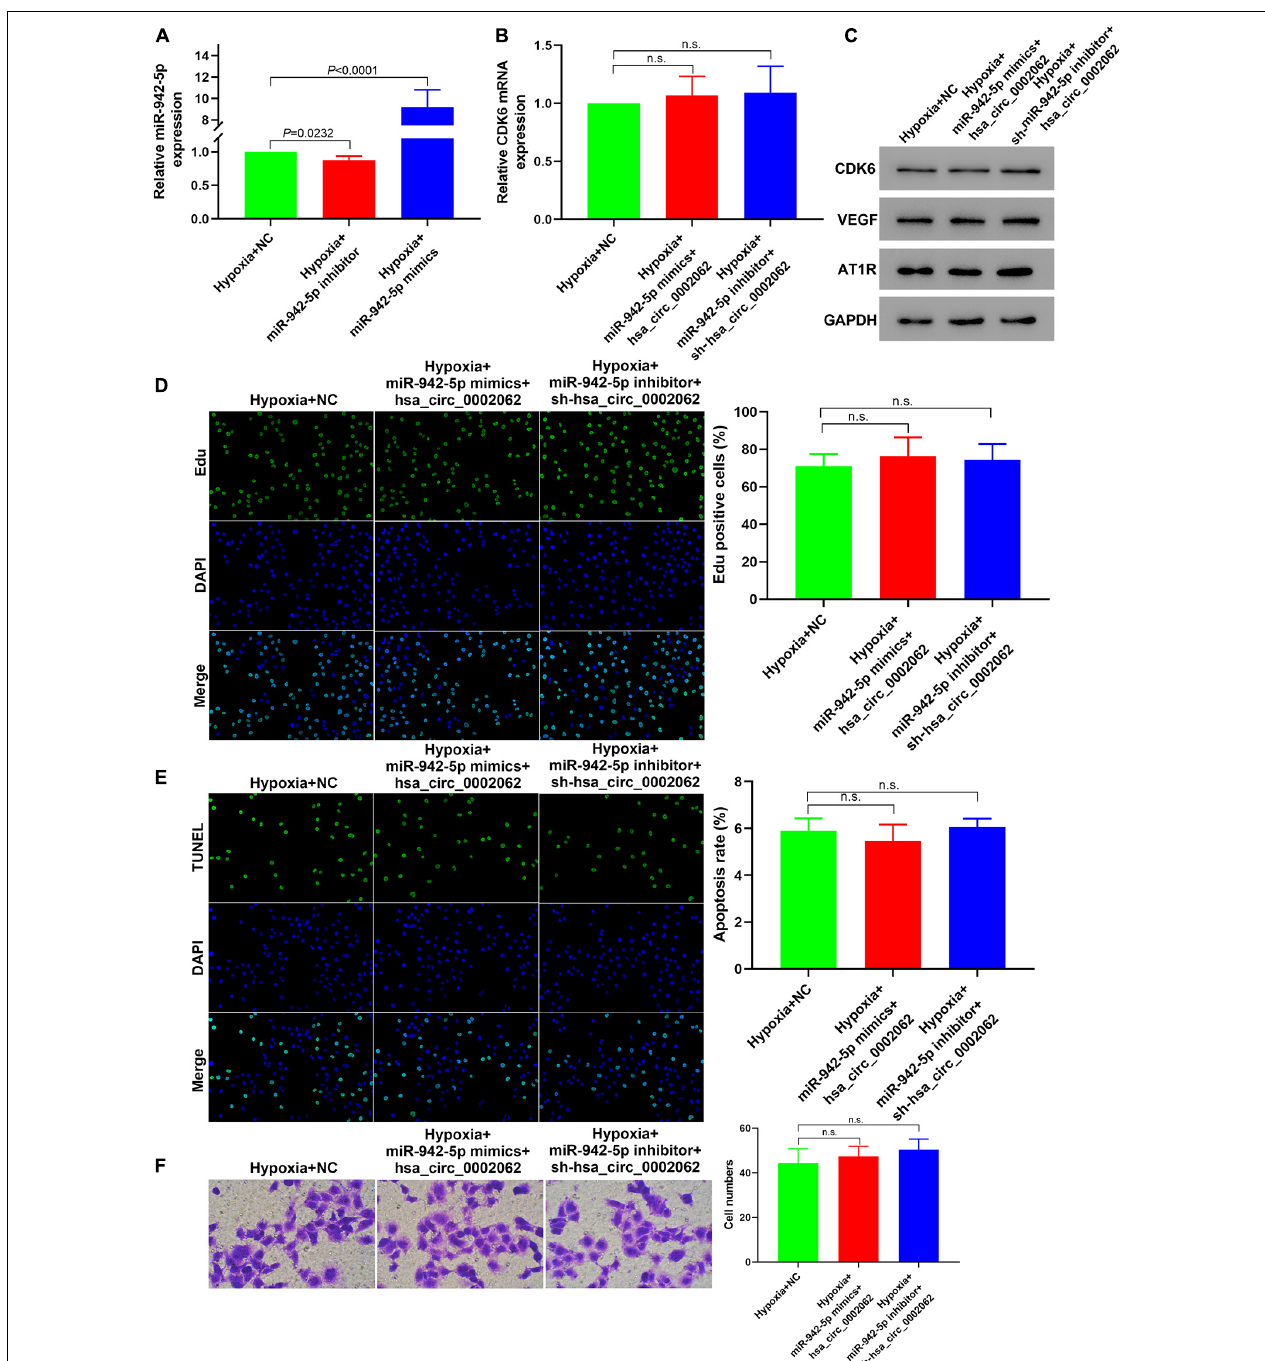
FIGURE 4 | Hsa-miR-942-5p reverses the hsa_circ_0002062-mediated promotion of cell proliferation and migration. (A) qRT-PCR indicated successful silencing and overexpression of hsa-miR-942-5p. (B–F) Co-transfection of miR-127-5p inhibitor and hsa_circ_0002062 siRNA, or hsa-miR-942-5p mimic and hsa_circ_0002062-overexpression plasmid in hPASMCs under hypoxia. There were no significant changes between groups in the expression level of CDK6 mRNA (B) protein levels of CDK6, VEGF and AT1R (C) , cell proliferation (D) , migration (E) , or cell apoptosis (F) . Image magnification: × 200. n.s.: no significant.